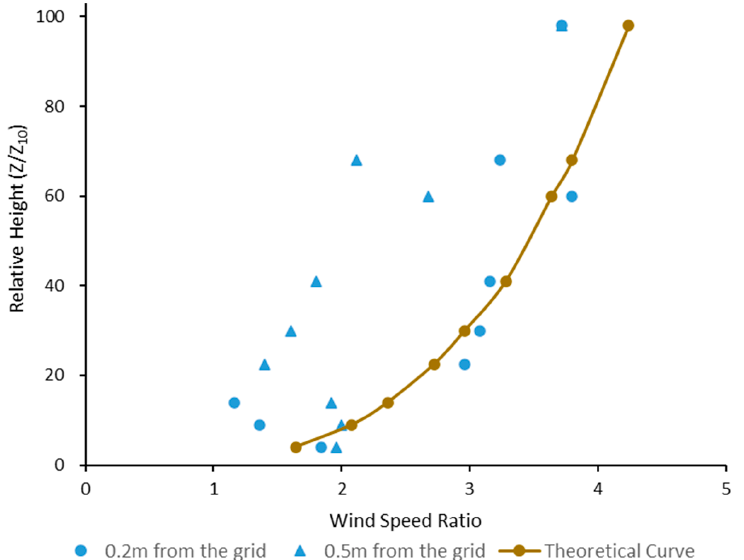
Figure 9. Comparison of the theoretical and measured wind speed ratios of the points near the wall boundary (case 1).